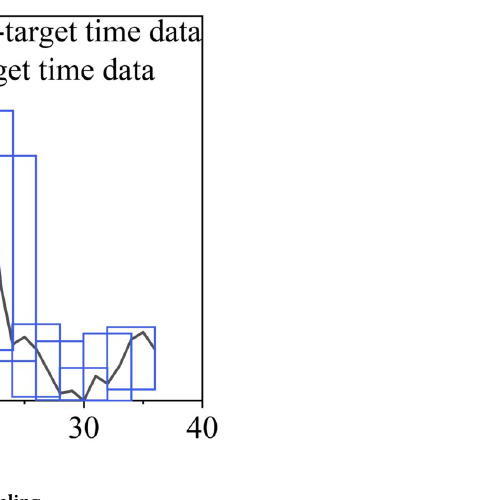
Fig 16. Sliding window discretized with 1